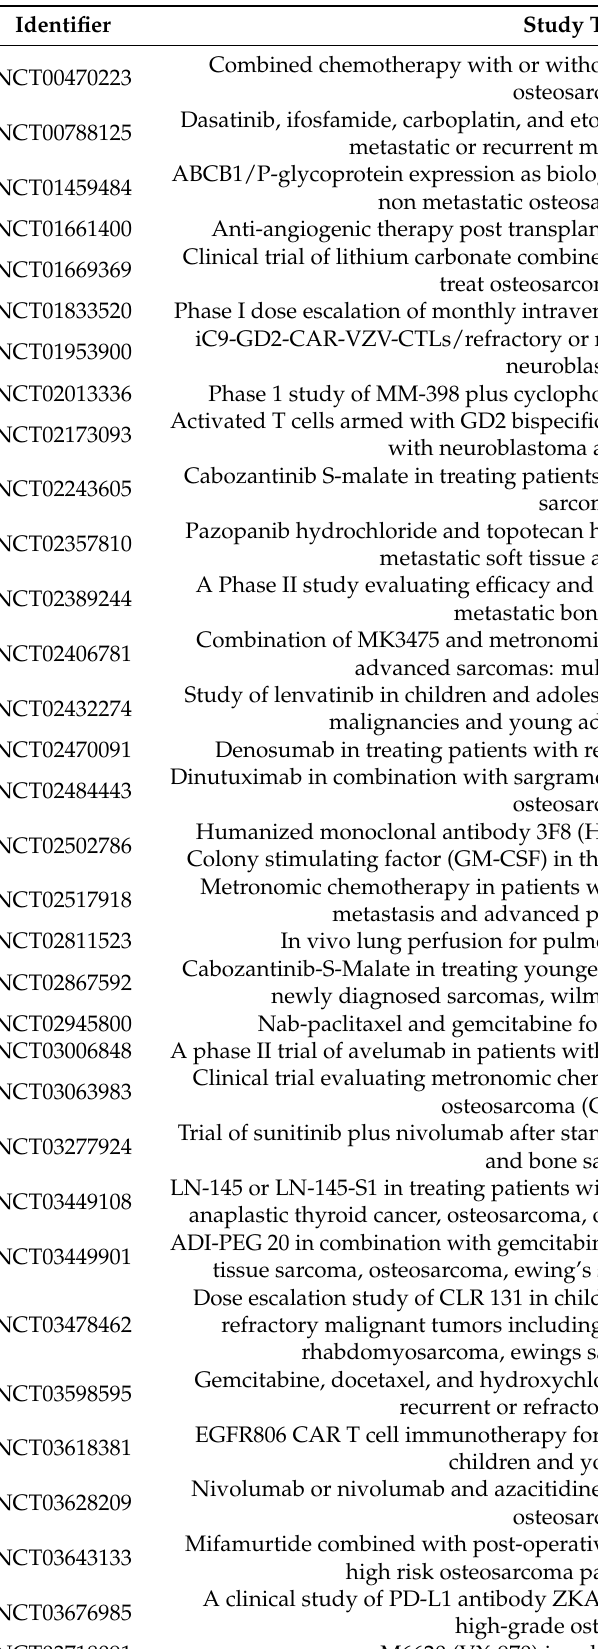
Table 1. Current and ongoing clinical trials in osteosarcoma using molecular targeted